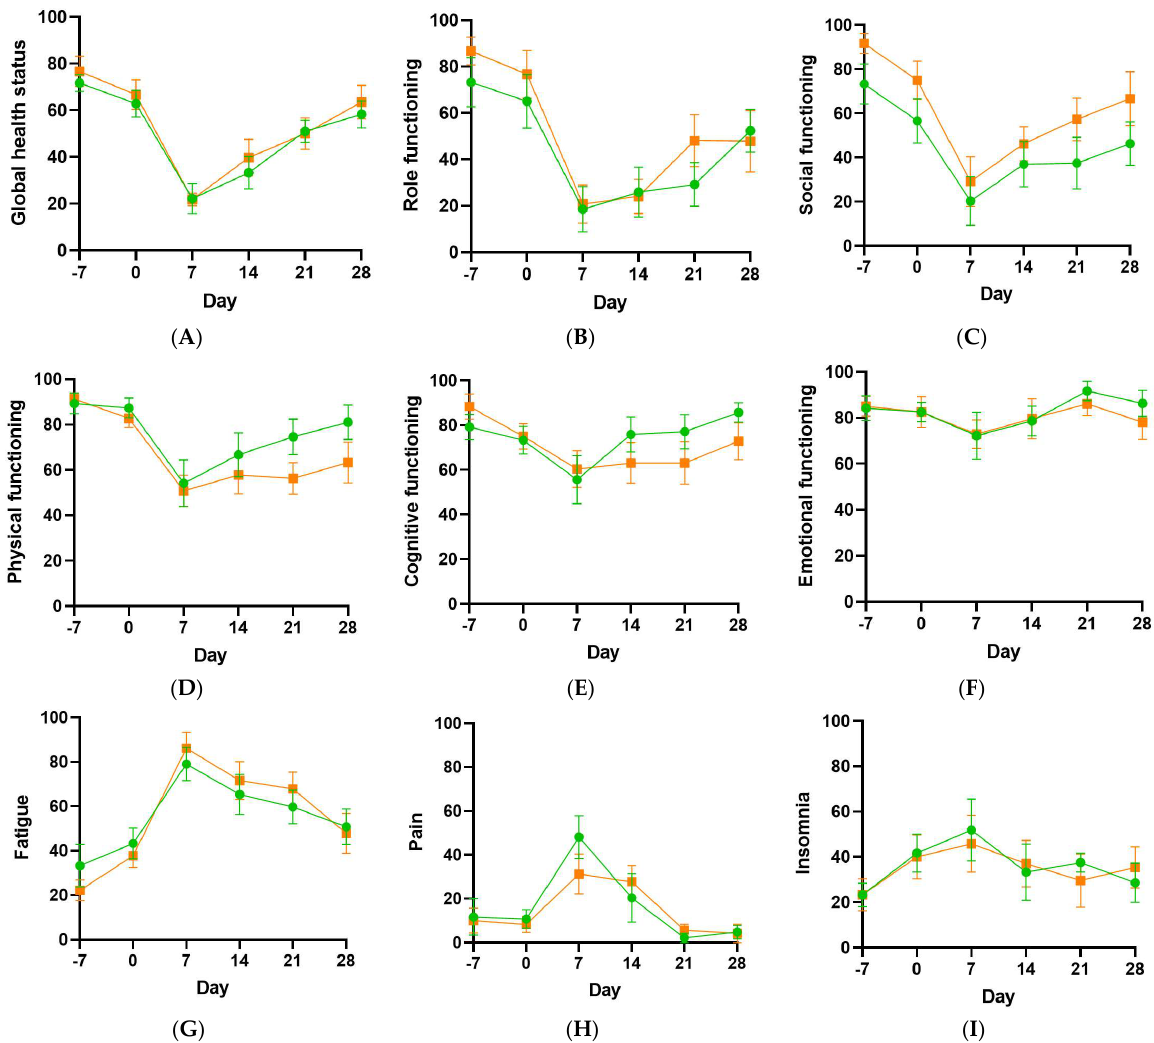
Figure 5. Functioning and selected symptoms in the vitamin C and placebo groups. Global health status ( A ), role functioning ( B ), social functioning ( C ), physical functioning ( D ), cognitive functioning ( E ), emotional functioning ( F ), fatigue ( G ), pain ( H ), insomnia ( I ), as determined by the EORTC QLQ. Placebo group, green circles; vitamin C group, orange squares.